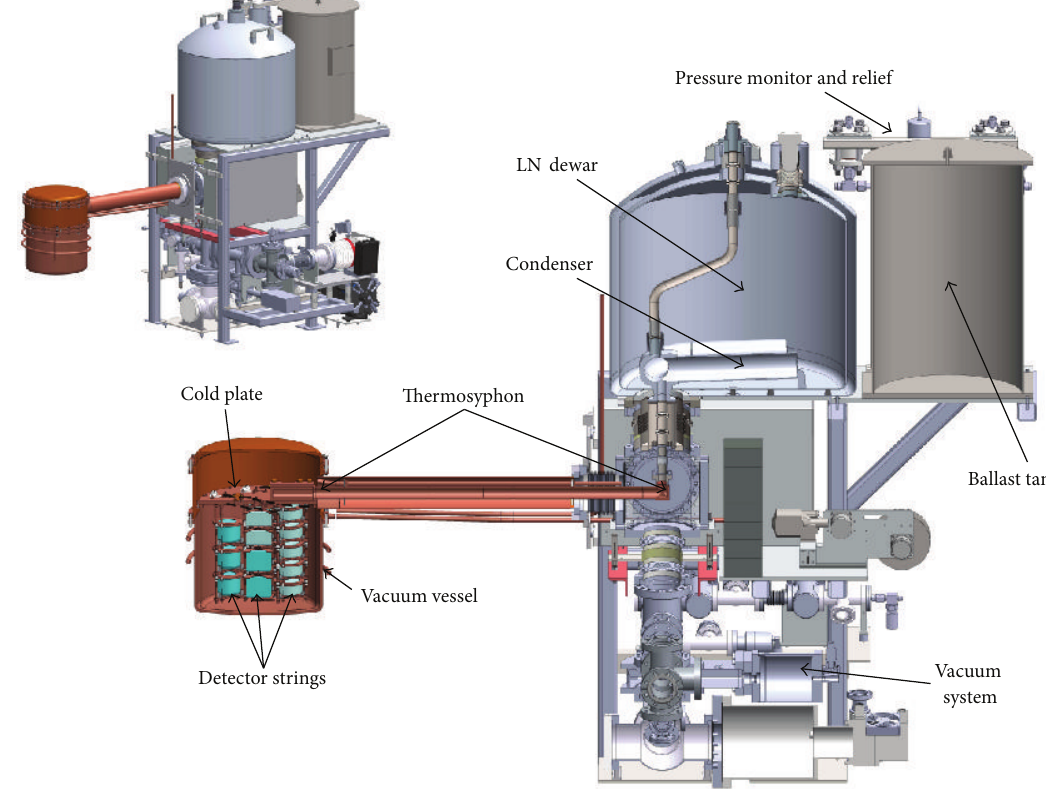
Figure 6: The Majorana Demonstrator module. Detector Strings are housed within ultralow background cryostats, each of which are supplied with its own vacuum and cryogenic systems (see text for details of vacuum and cryogenic system